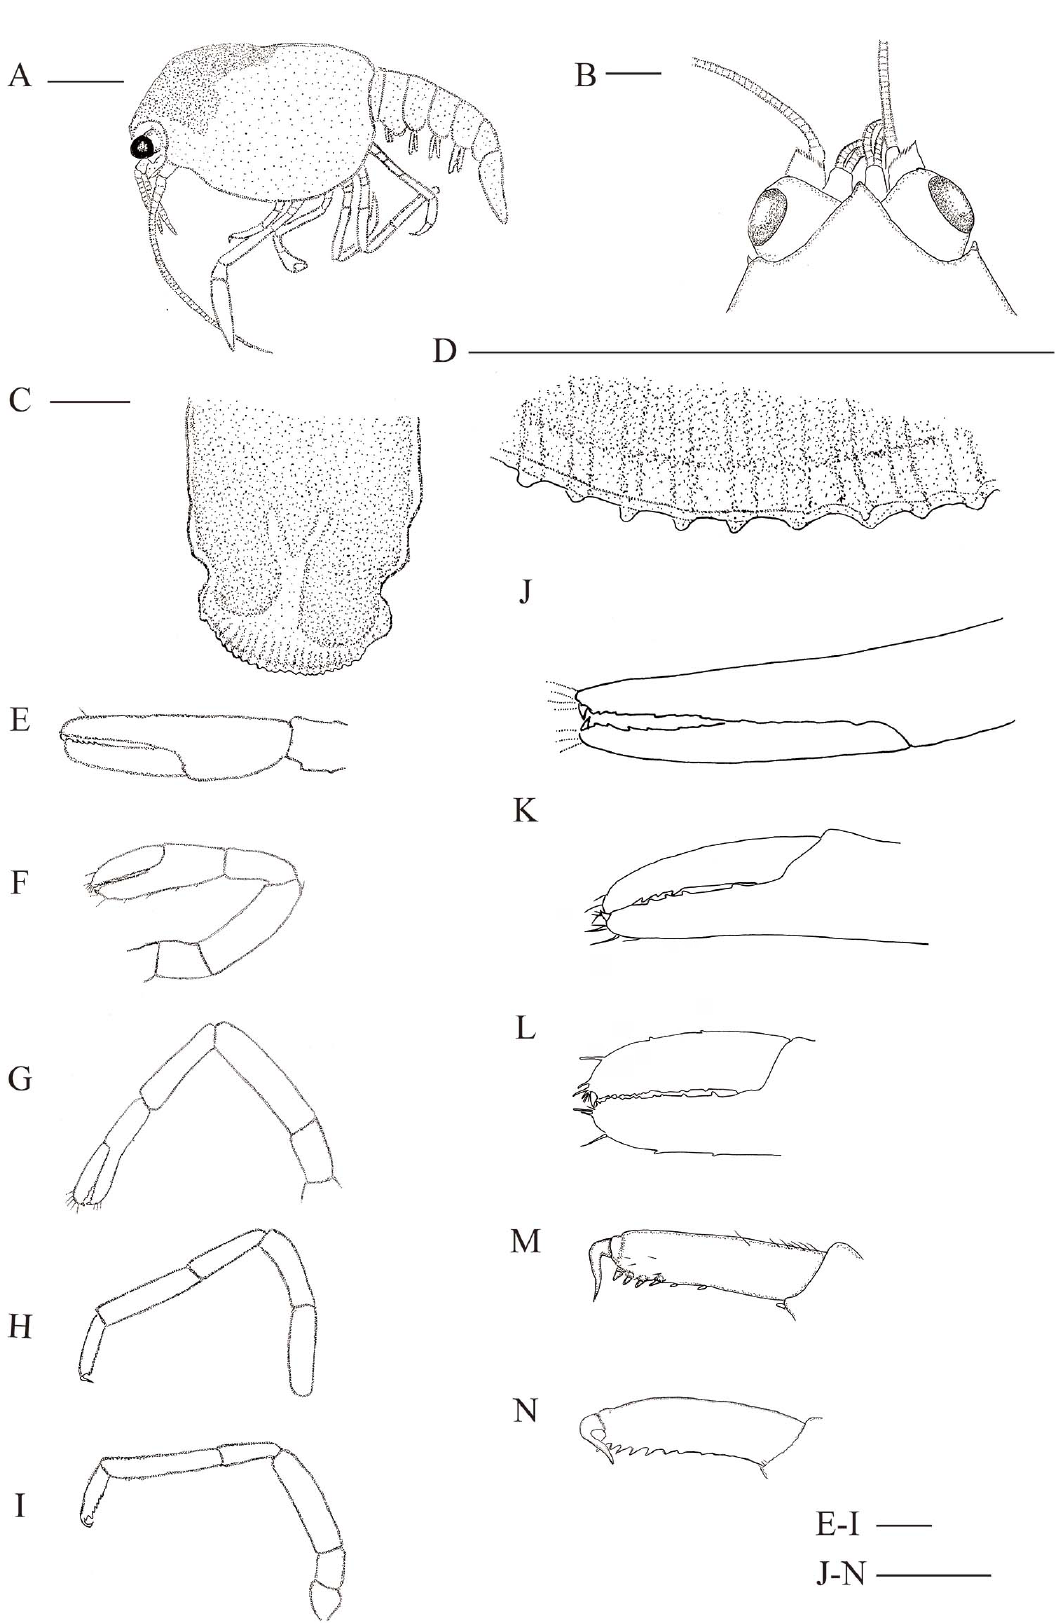
Figure 21. Juvenile Stage II of Cherax destructor . ( A ) Habitus, lateral view; ( B ) eyes and rostrum, dorsal view; ( C ) tail fan, dorsal view; ( D ) posterior edge of tail fan; ( E–I ) pereiopods 1–5, dorsal or lateral view; ( J–N ) distal segments of pereiopods 1–5, dorsal or lateral view. Scale bars: 0.25